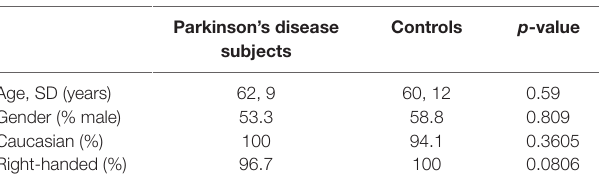
Parkinson’s disease